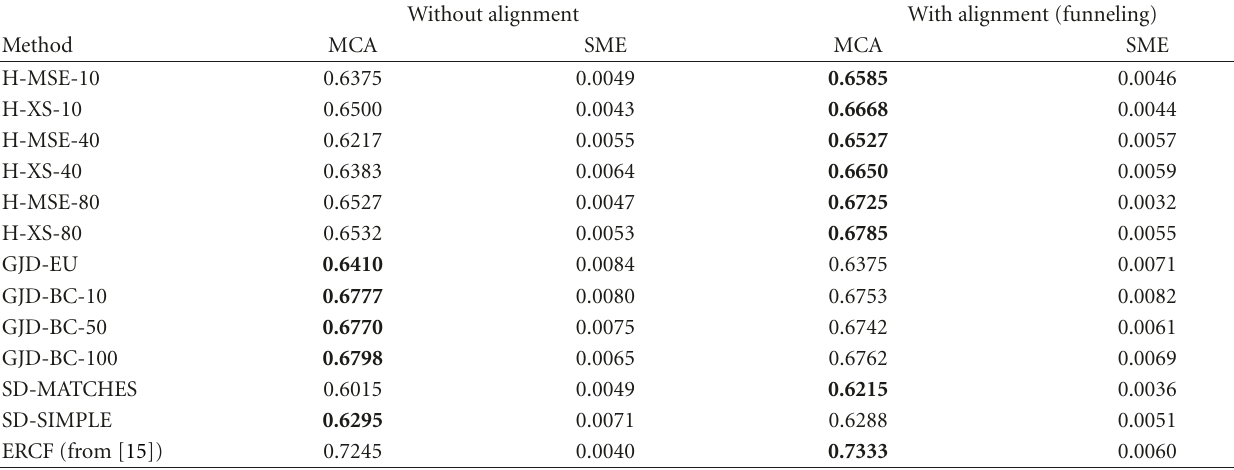
Table 3: Correct classification rates (LFW database, restricted setting). Experiments were performed on cropped regions of size 100 × 185 ( nw = 2 . 4 and nh = 4 . 4), except for ERCF that considers the full image. MCA: Mean classification accuracy. SME: Standard error of the mean. In bold are the best results of each method.